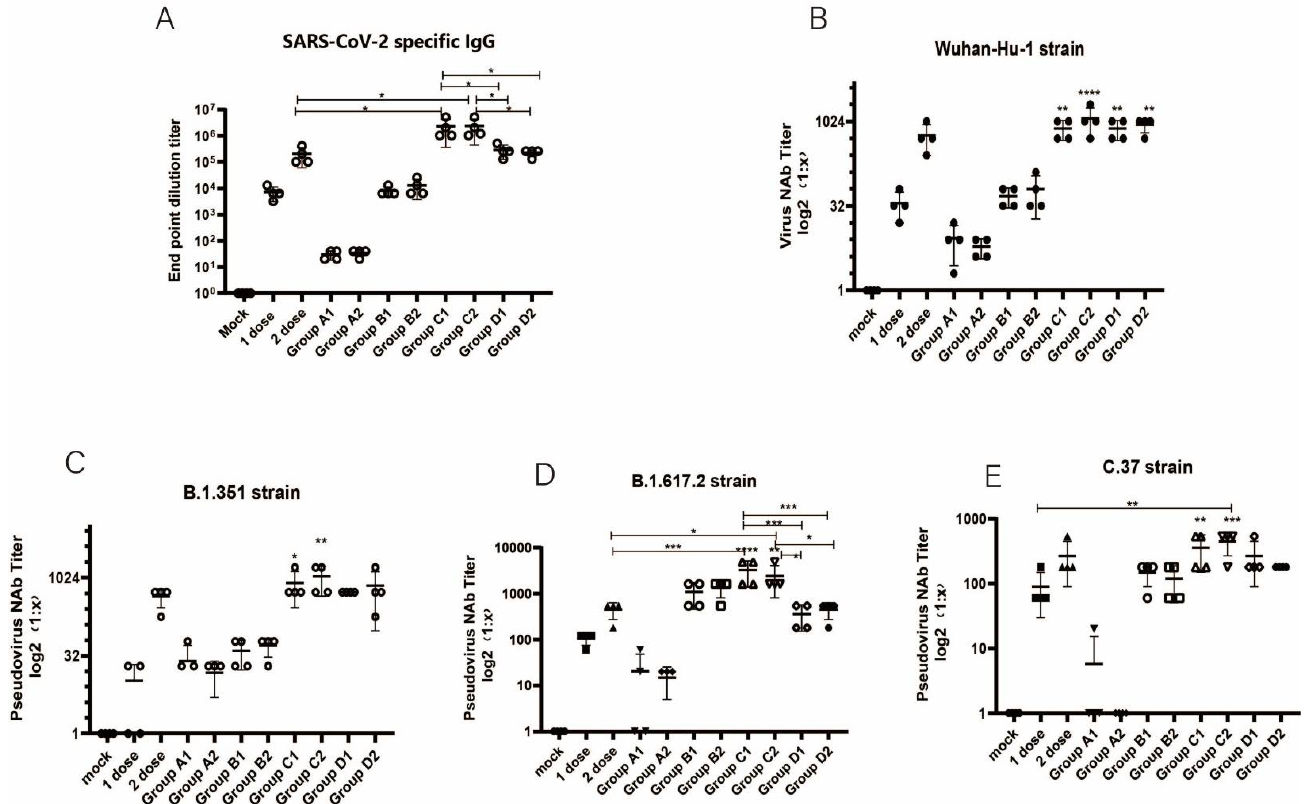
Figure 3. Antibody responses to different group designs: ( A ) Titers of SARS-SoV-2 S1-specific total IgG analysis (Wuhan-Hu-1 strain). ( B – E ) Neutralizing antibody (NAb) titers against the ( B ) Wuhan-Hu-1, ( C ) B.1.351, ( D ) B.1.617.2, and ( E ) C.37 strains. The latter three variants were tested by pseudovirus